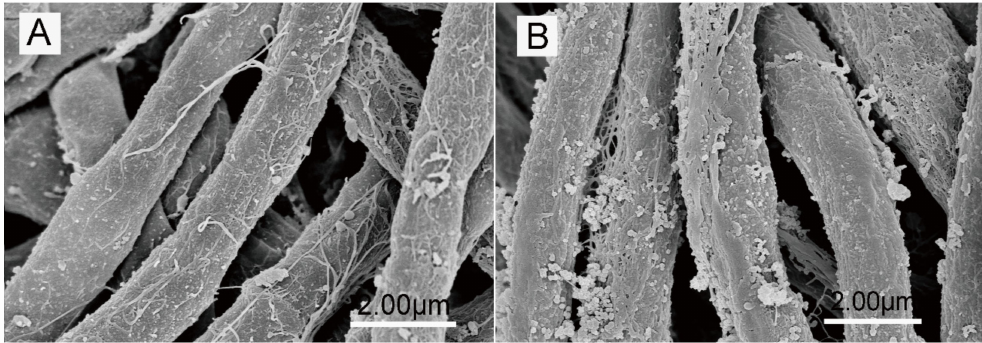
Figure 1. Scanning Electron Microscope (SEM) images of R. solani ( A ) without PEF treatment and ( B ) after PEF treatment (the experimental condition is at 20 kV, 3 min., 45 µ